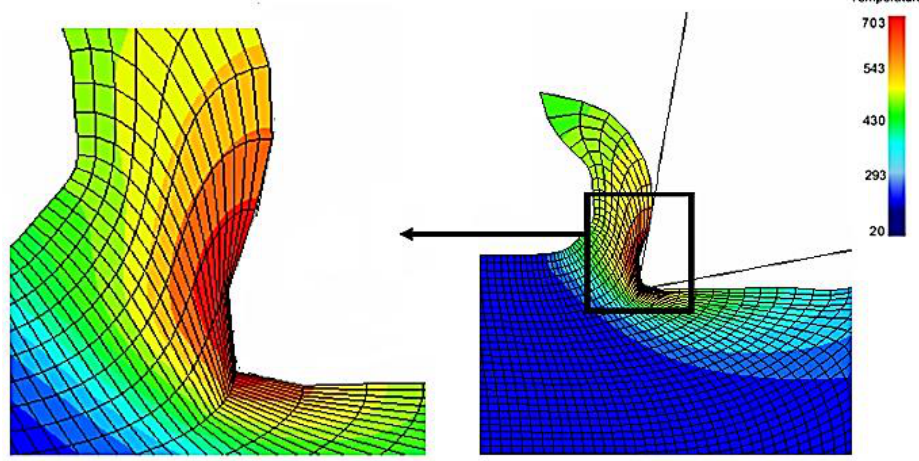
Figure 14. Temperature distribution with Vc = 50 m/min.